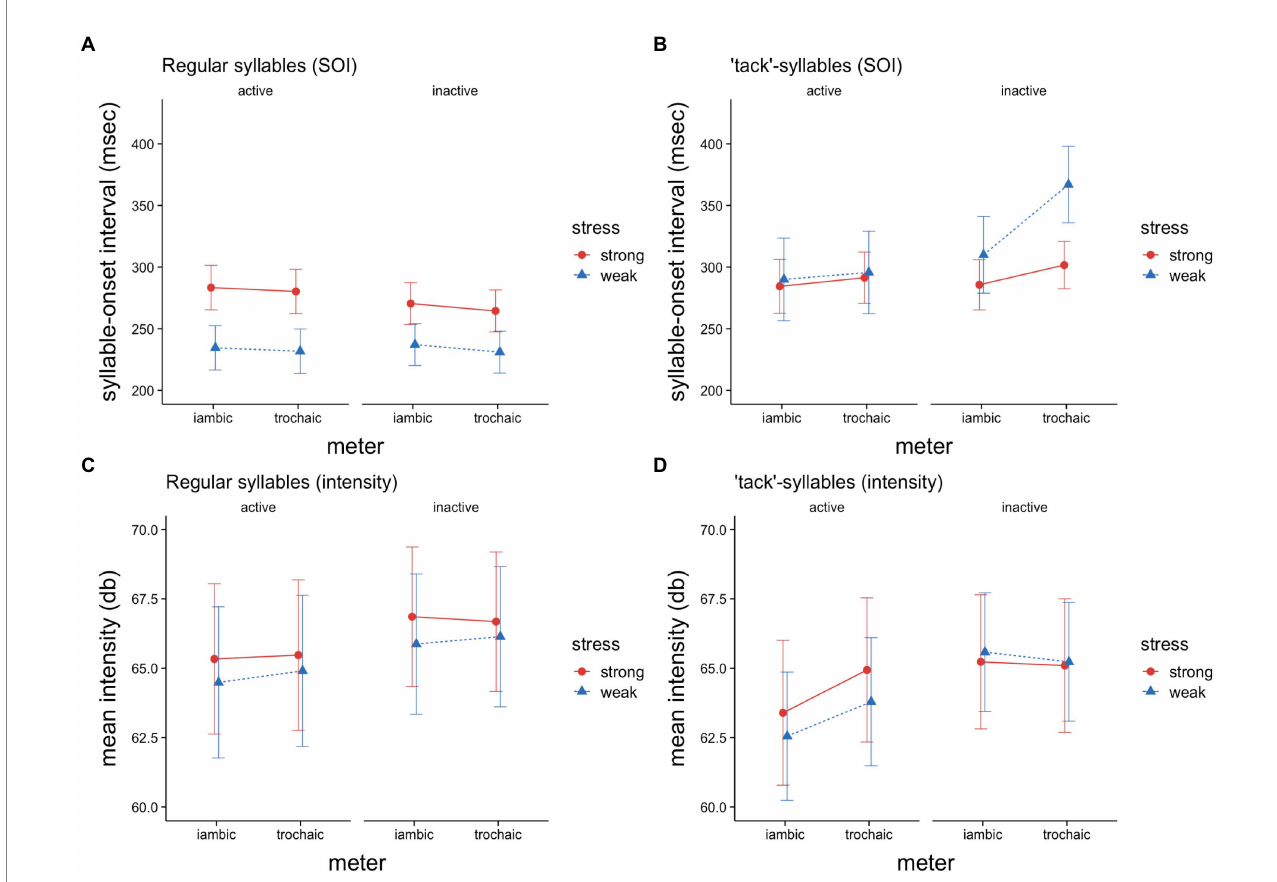
FIGURE 1 Syllable-onset intervals (A,B) and syllable intensities (C,D) for regular syllables (A,C) and ‘ tack’-syllables (B,D) , as a function of stress (strong vs. weak), meter (iambic vs. trochaic), and musical activity (active vs. not active). The whiskers depict 95% confidence